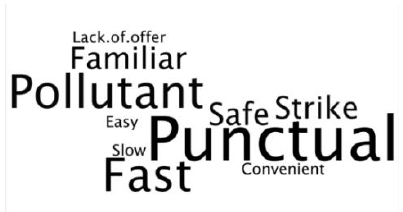
Figure 4. Word cloud of river transport outside Lisbon municipality.